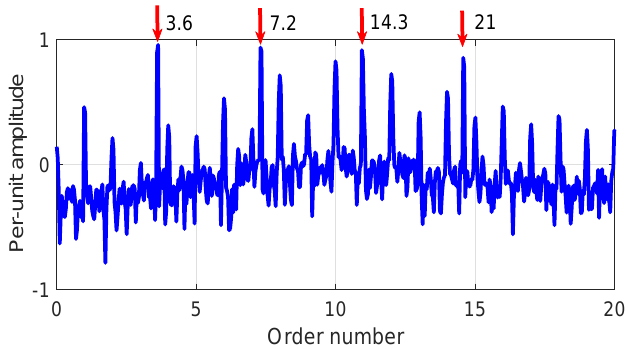
Figure 4. Order analysis of the generator bearing signal suggesting outer race fault frequency order excitation (red